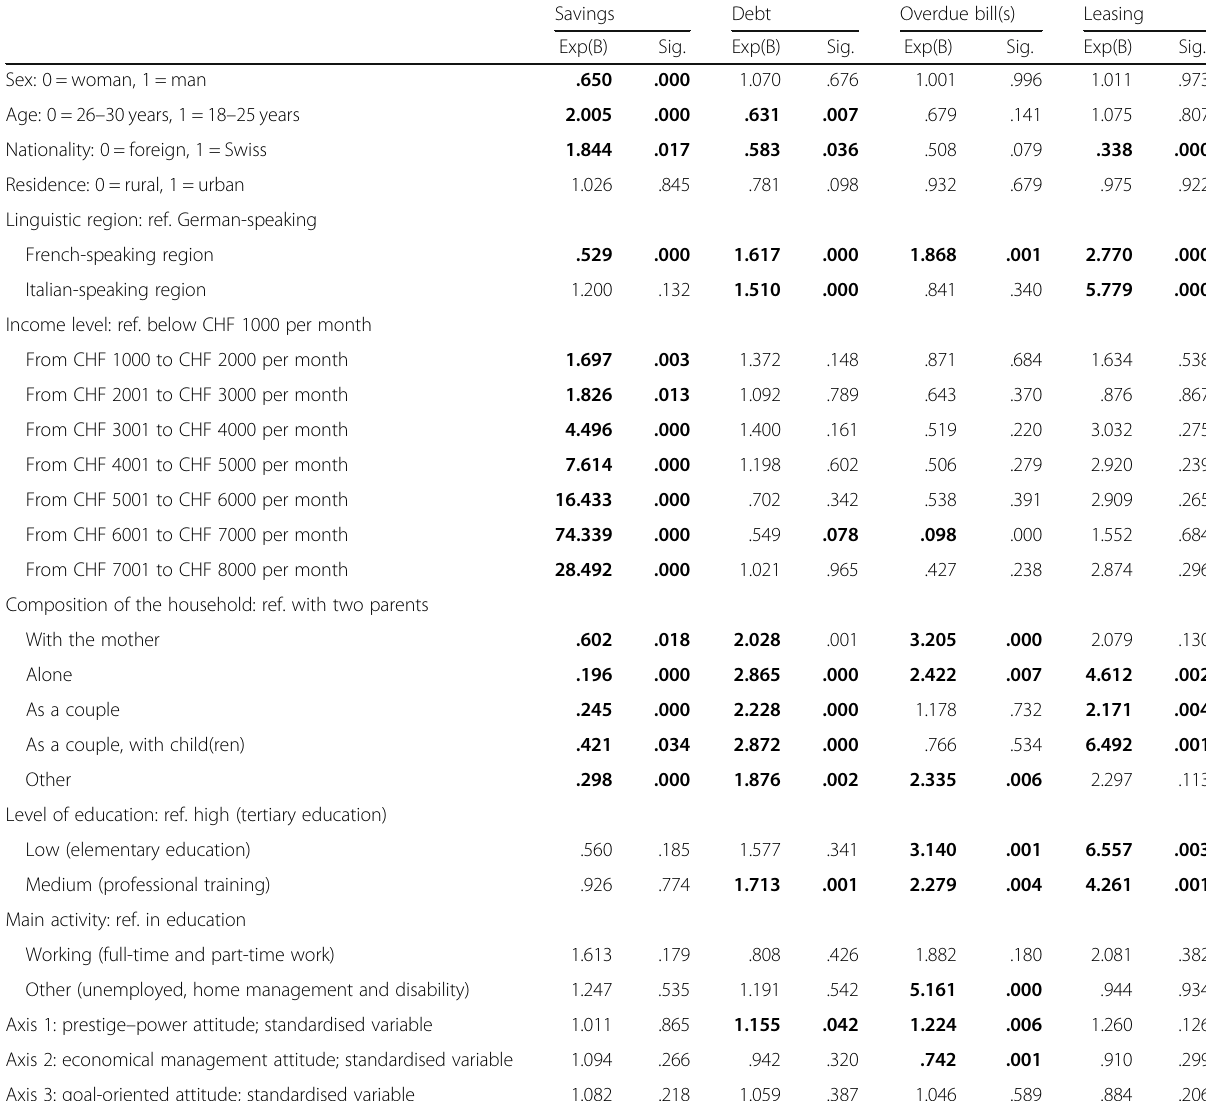
Table 4 Multilevel binary logistical regression analyses for savings and indebtedness